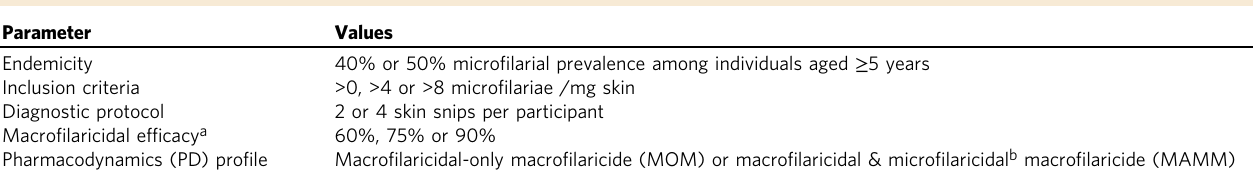
(Fig. 4b, d). Inference on opportune follow-up timeframes is qualitatively very similar between the lower and upper end of the mesoendemicity setting, albeit there is noticeably greater varia- tion in the difference between the micro fi larial intensity outcome measure at the upper endemicity end of the setting (compare Supplementary Fig. S2a, b with Fig. 4a, b). Estimated sample sizes . The sample size required to achieve a given statistical power to detect a difference between (ivermectin-